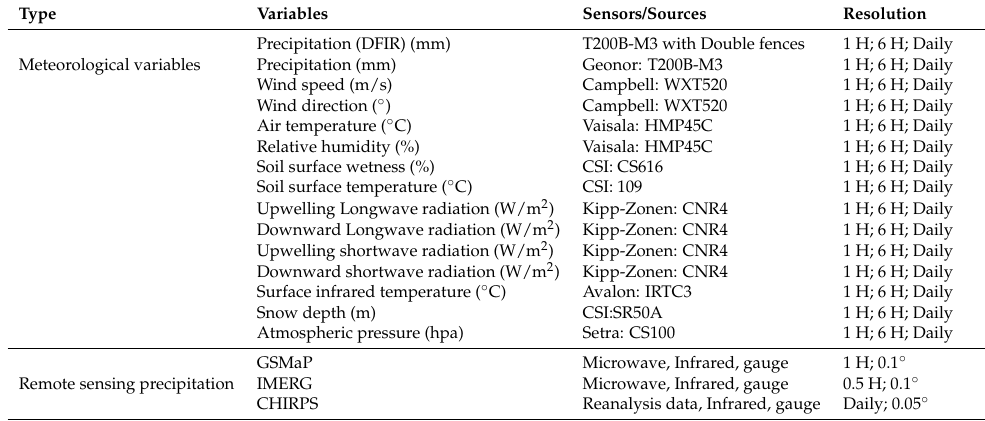
Table 1. The meteorological variables and remote sensing data used in this study. The temporary and spatial resolutions are listed for the remote sensing data. The temporary resolutions are listed for the data on the Yakou